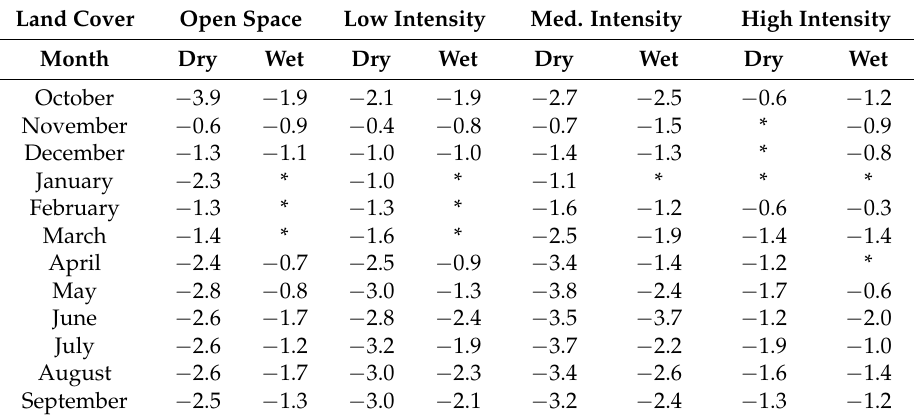
Figure 3. Box plots for low and high water-use areas of low intensity LC. Similar to Figure 2 for a ( top ) dry year and ( bottom ) wet year. During the spring and summer months of the dry year, irrigations impact on the LST is greater than during the wet year; all mean differences are significant ( p < 0.01) except for “*”. See Table 2 for mean differences for all land cover types. Table 2. Mean differences between high and low irrigation rates for dry (WY20002) and wet (WY2005) years for each month and land cover